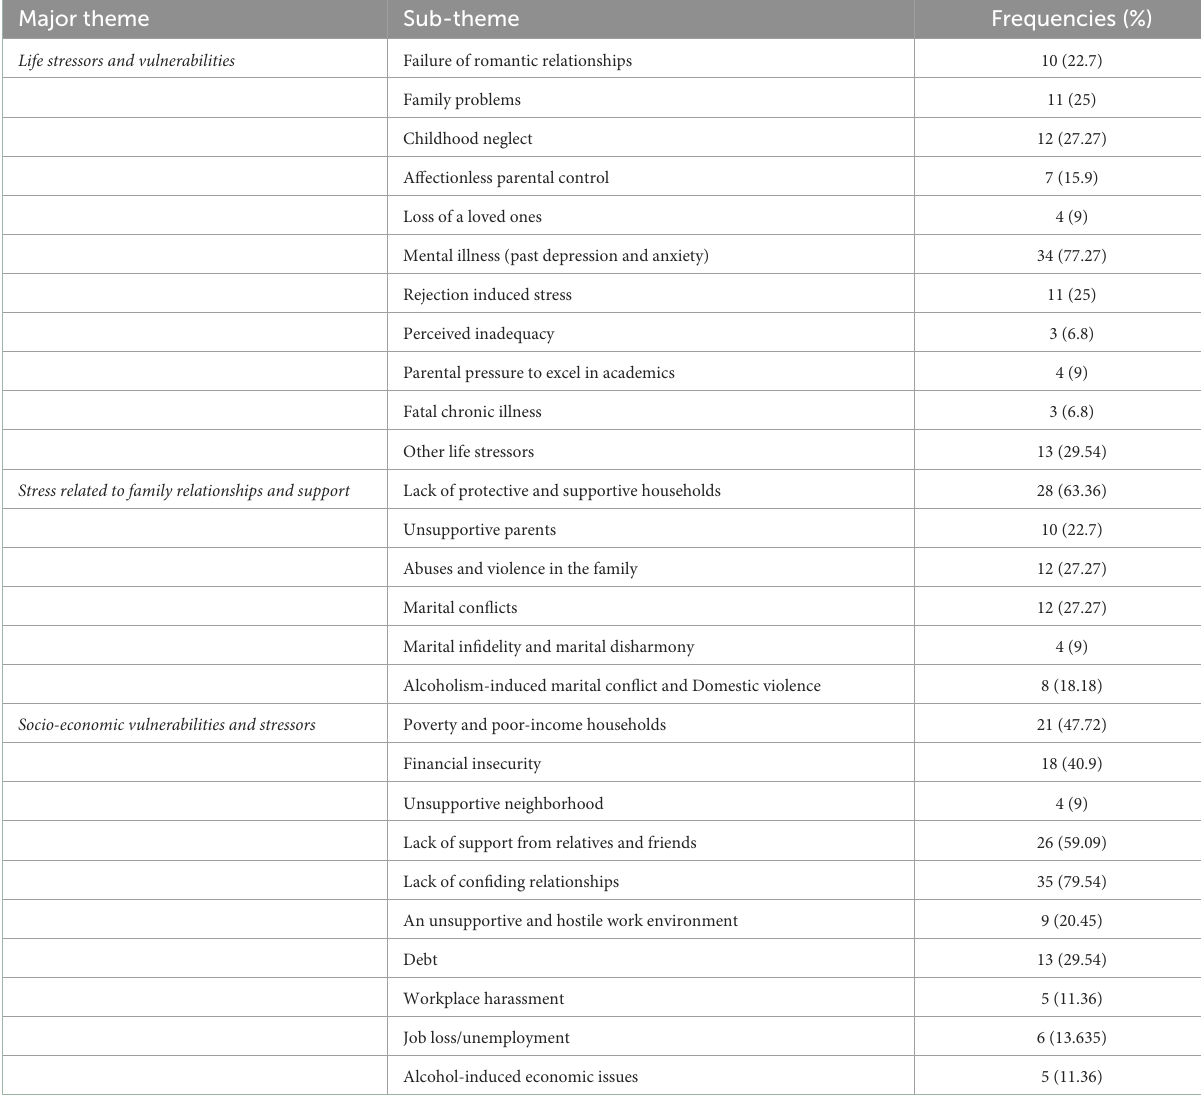
TABLE 4 Qualitatively explored risk and vulnerability factors associated with suicide. Major